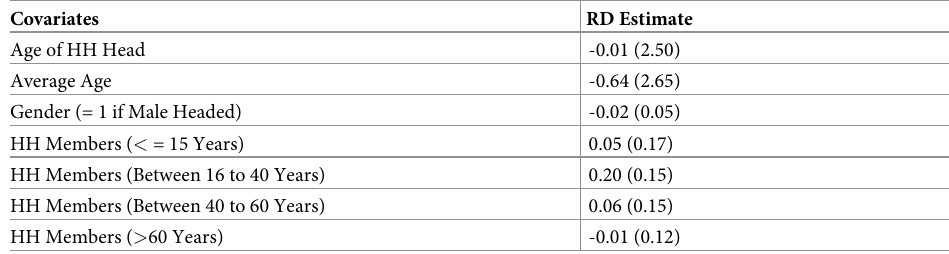
Table 5. RD Estimates to check discontinuity in